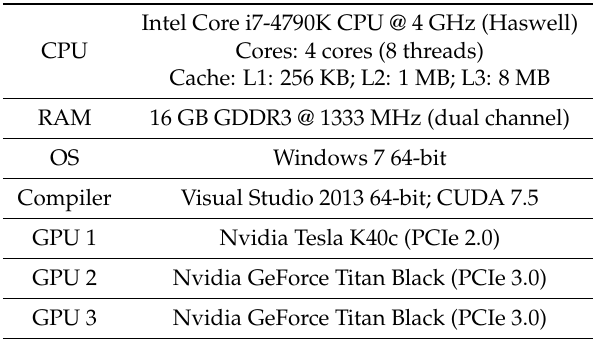
Table 1. Details of the primary test